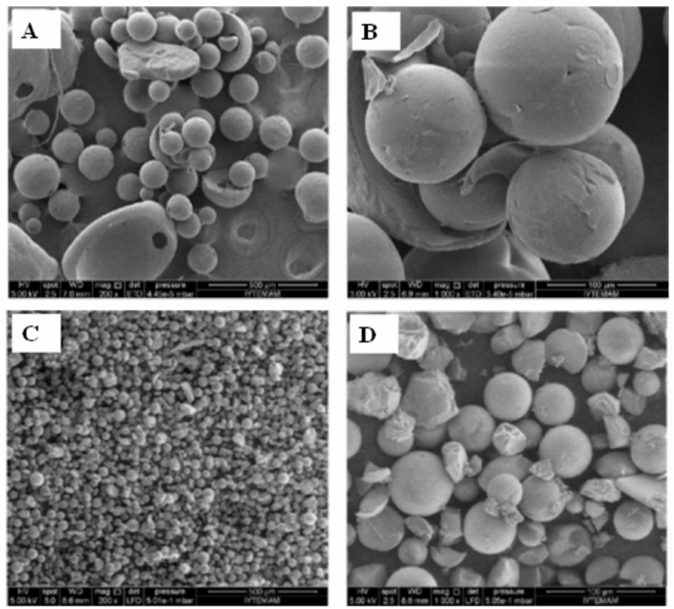
Figure 3. Scanning electron micrographs of polycaprolactone alone ( A , B ) and encapsulated with rosemary extract by GAS ( C , D ). Adapted from Yesil-Celiktas and Cetin-Uyanikgilb